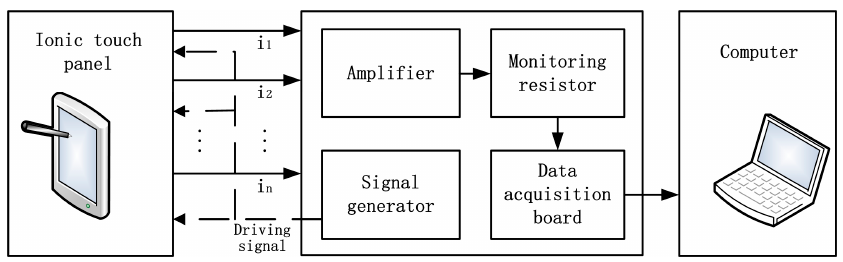
Figure 2. Block diagram of the measurement setup.